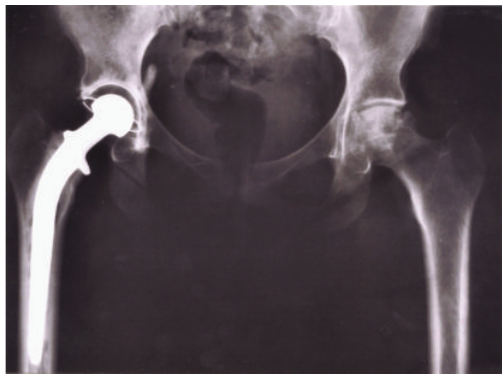
Figure 12: Hip X-ray image showing total replacement at left (right side) (from